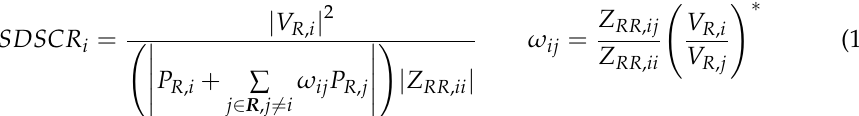
Figure 14. Three-phase fault applied at bus 6 in the transmission side of the testbed: ( a ) instantaneous voltage and current at bus 634 with increased loading; ( b ) instantaneous voltage and current at bus 680 with increased loading.